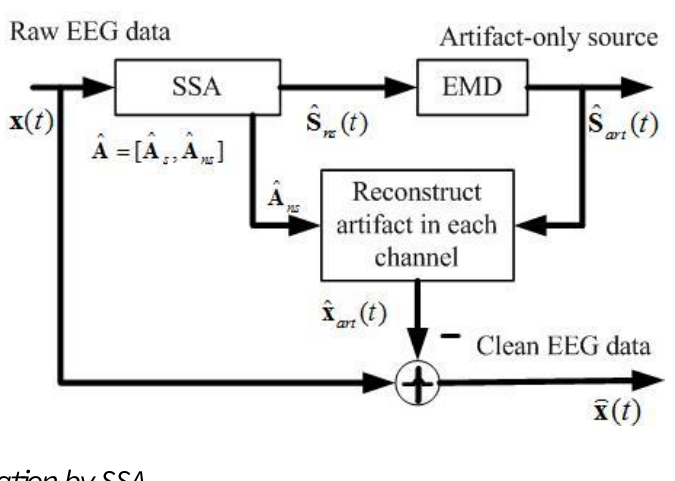
Figure 1. Block diagram of the proposed